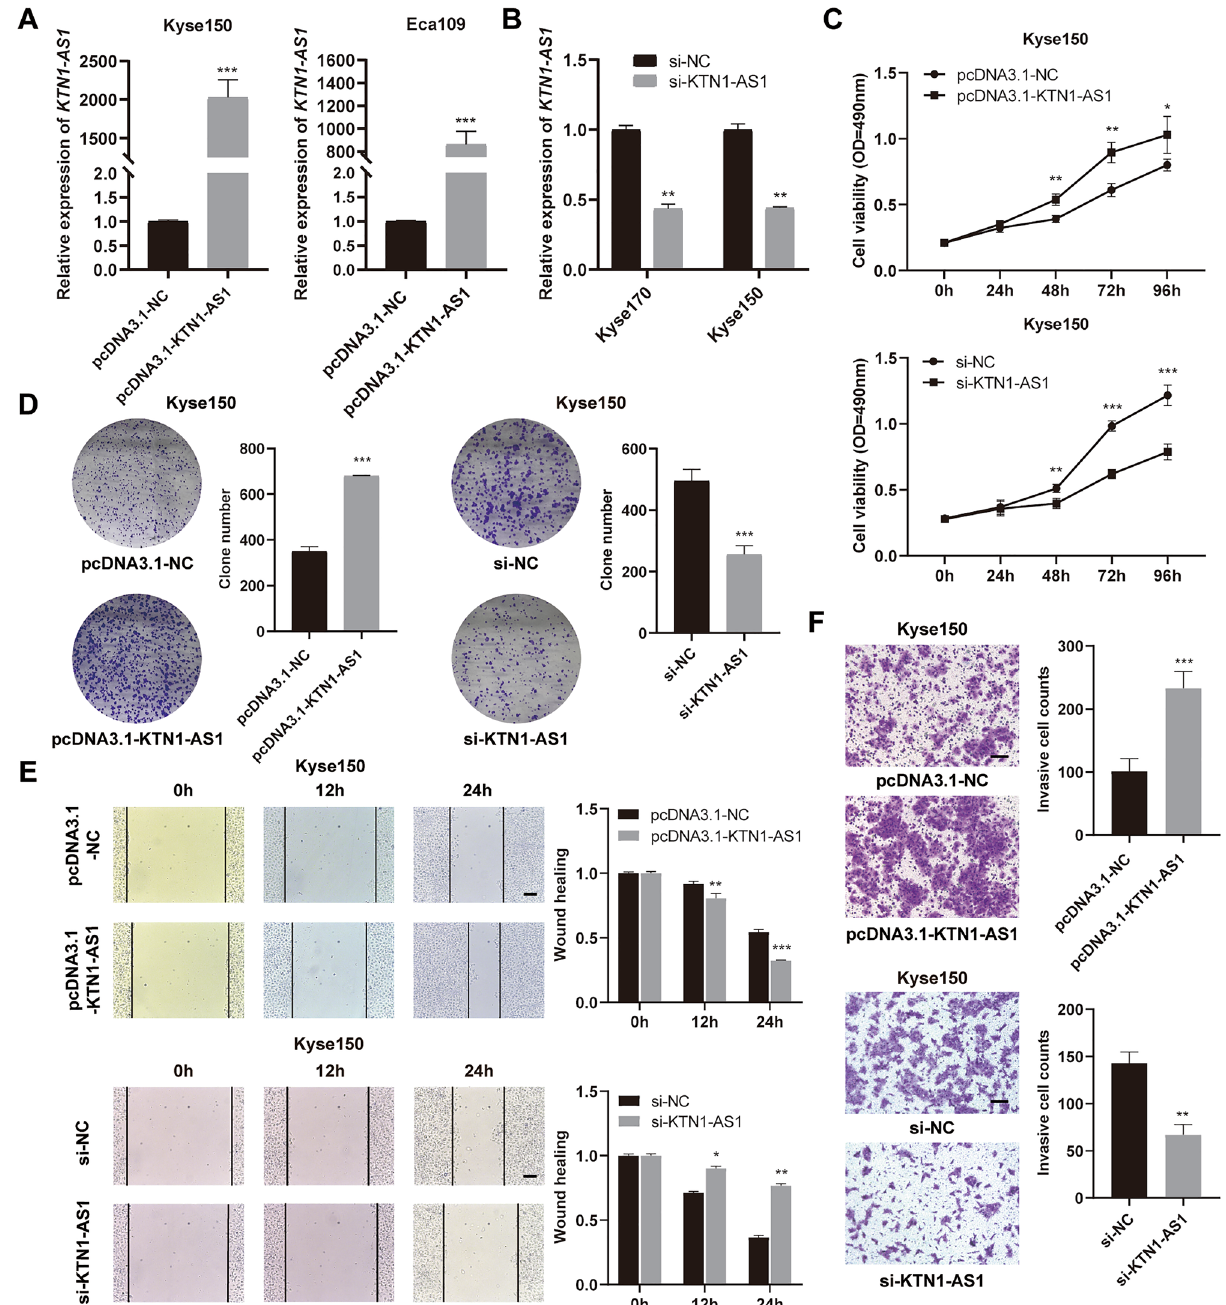
Figure 3. KTN1-AS1 facilitates esophageal squamous cell carcinoma (ESCC) cells biological functions. ( A , B ) The overexpression efficiency of KTN1-AS1 in Kyse150 and Eca109 cells, and the knockdown efficiency of KTN1-AS1 in Kyse170 and Kyse150 cells. ( C , D ) MTS and clone formation assays were used to demonstrate the cell proliferation ability in Kyse150 cells in response to upregulation and downregulation of KTN1-AS1 . ( E , F ) Cell migration and invasion ability were verified through wound healing and transwell assays in Kyse150 cells by overexpressing and downregulating KTN1-AS1 (magnification: ×100). Error bars are shown as mean ± SD from three replicate experiments (n = 3) (* P < 0.05, ** P < 0.01, *** P <